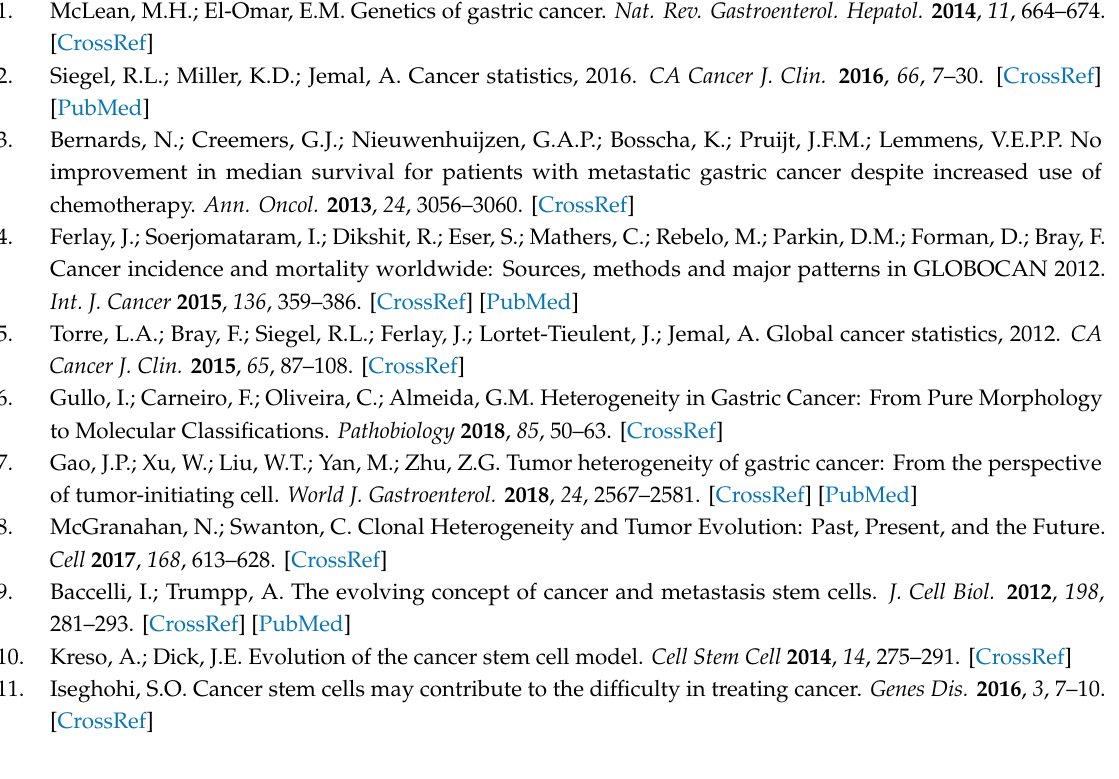
Table S1: Significant KEGG pathways by predicted upregulated miRNAs; Table S2: Significant KEGG pathways by predicted downregulated miRNAs; Figure S1: PRISMA flow